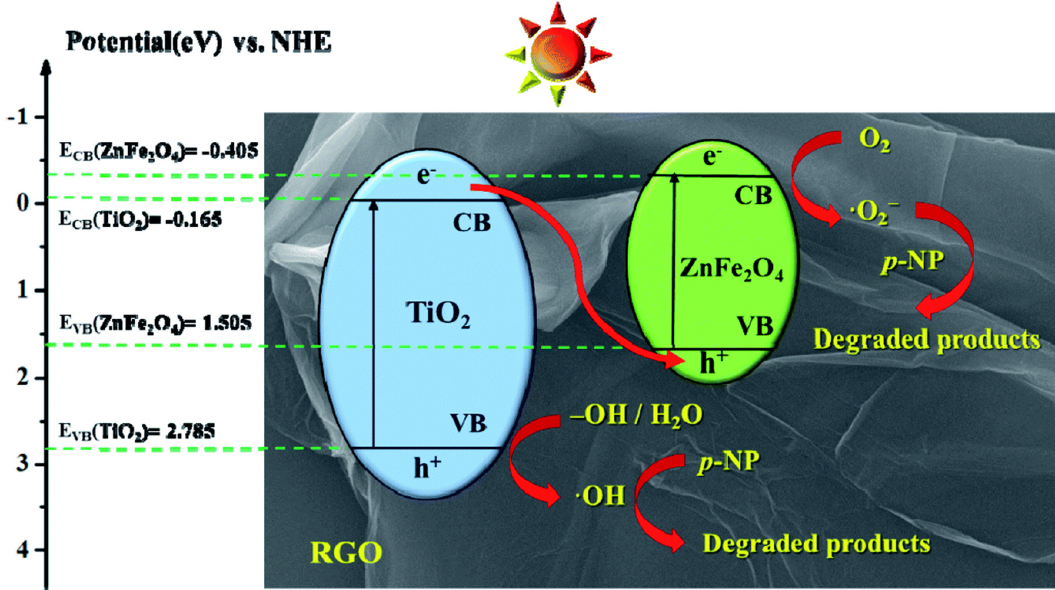
Figure 4. Possible mechanism for the formation of reactive oxygen species by TiO 2 /ZnFe 2 O 4 /rGO